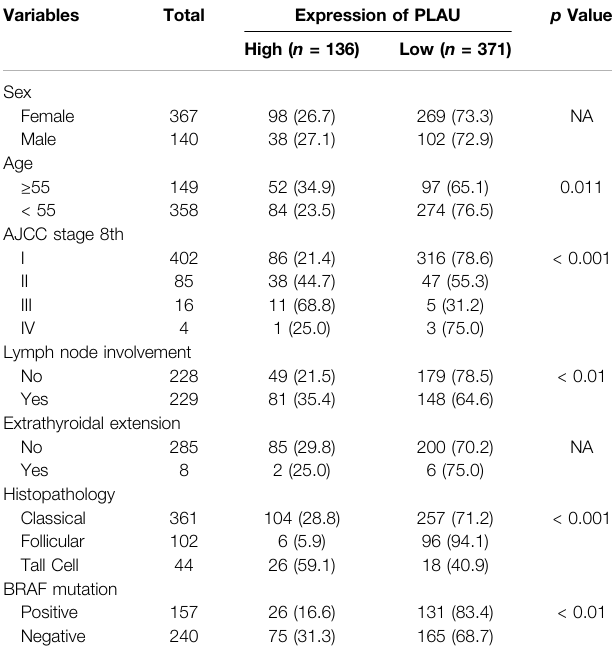
TABLE1| CorrelationbetweenPLAUexpressionandclinicalcharacteristicsinthe TCGA cohort.